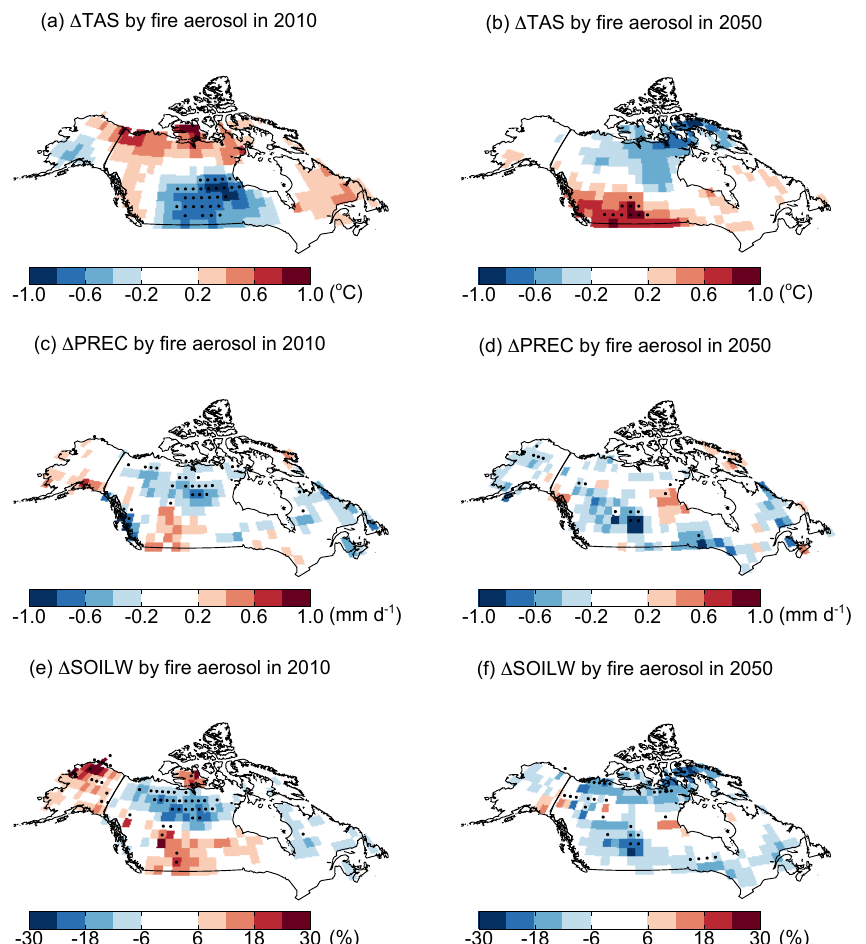
Figure 11. Predicted changes in summertime (a, b) surface air temperature, (c, d) precipitation, and (e, f) soil water content at surface caused by aerosols from wildfire emissions at (a, c, e) present day and (b, d, f) mid-century. Results for temperature and precipitation are shown as absolute changes. Results for soil water are shown as relative changes. Results for the 2010s are calculated as F10AERO–F10CTRL. Results for the 2050s are calculated as F50AERO–F50CTRL. Significant changes ( p < 0 . 05) are marked with black dots.